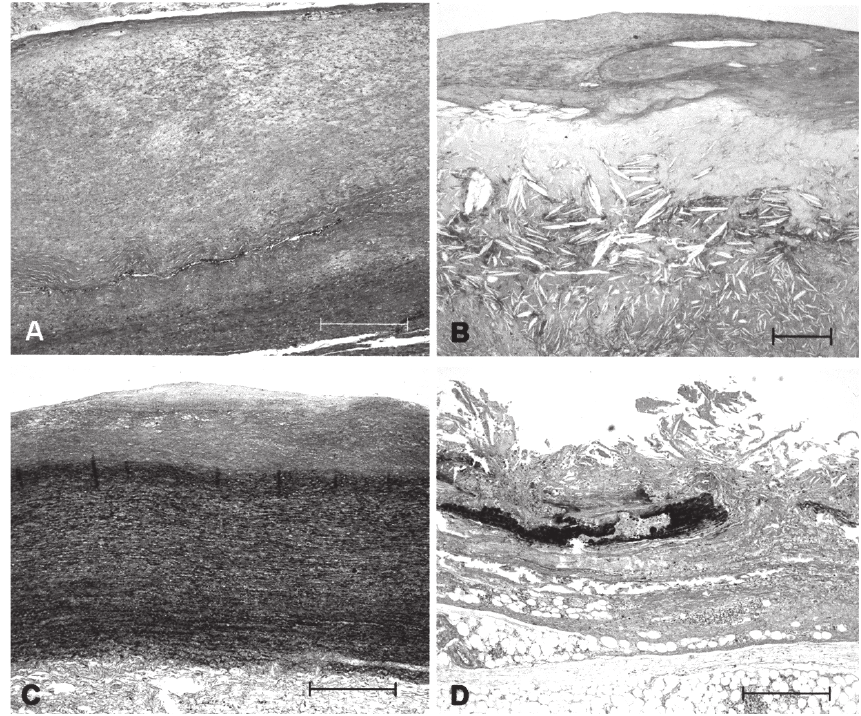
Figure 1 - Atherosclerotic lesions showing: (A) thick fibrous plaque; (B) fat plaque with many cholesterol clefts; (C) small fibrous plaque and preserved medial layer; (D) superficial ulceration and medial layer presenting massive destruction of elastic fibers. A and B Masson’s trichrome stain; C and D Verhoeff’s stain for elastic fibers. Bar = 500